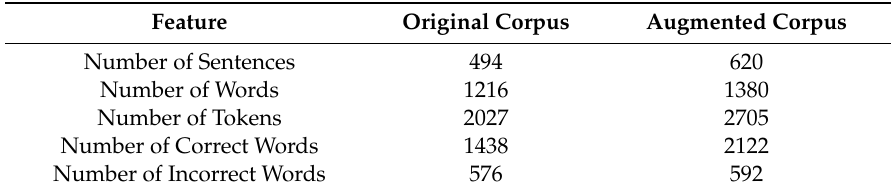
Table 2. Corpus Statistics.